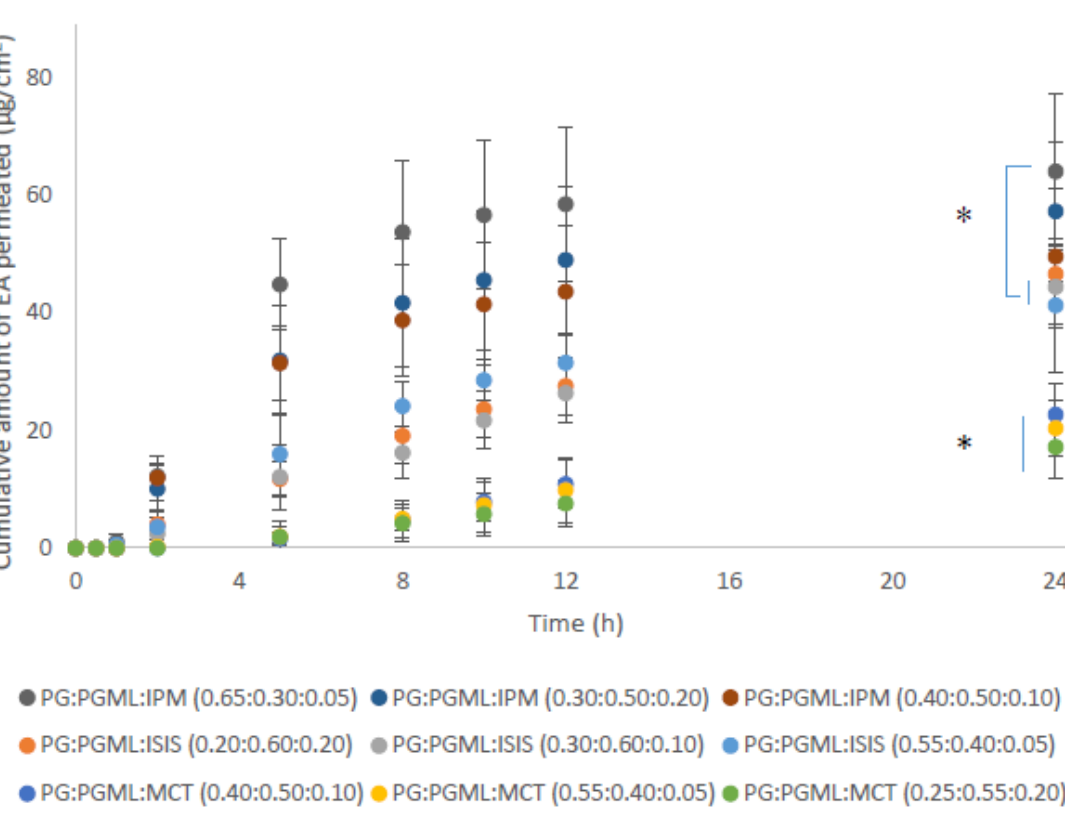
Figure 4. Cumulative permeation of 3-O-ethyl l-ascorbic acid over time for various ternary solvent systems ( n = 5; mean ± SD, * p < 0.05).